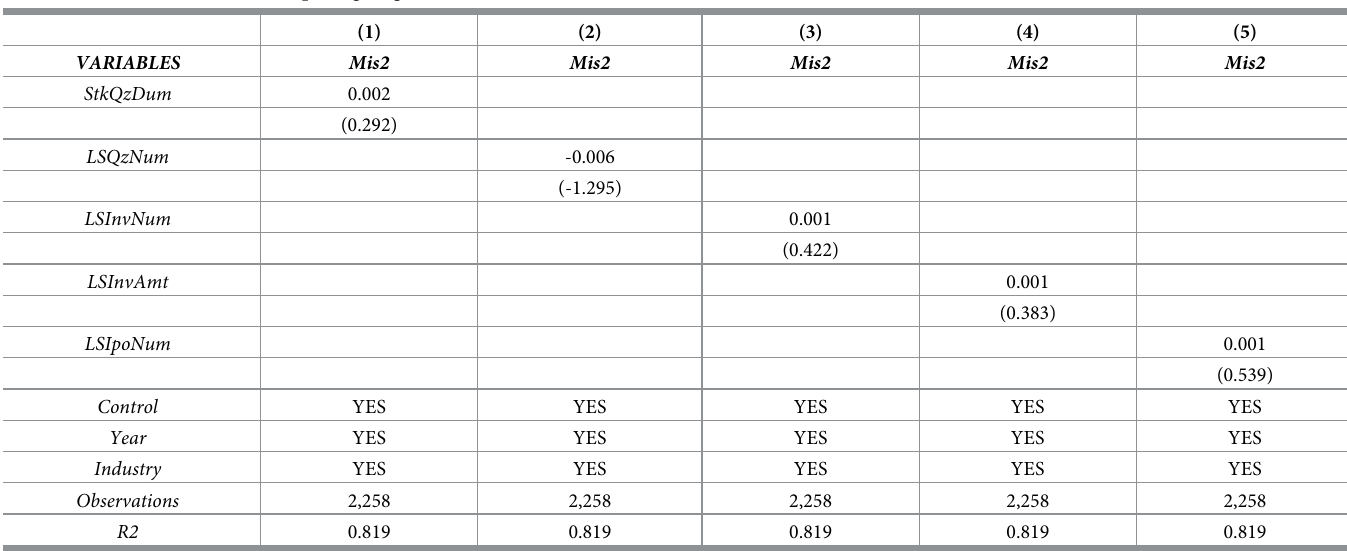
Table 13. VC Quan Zi and asset mispricing (negative)—Alternative